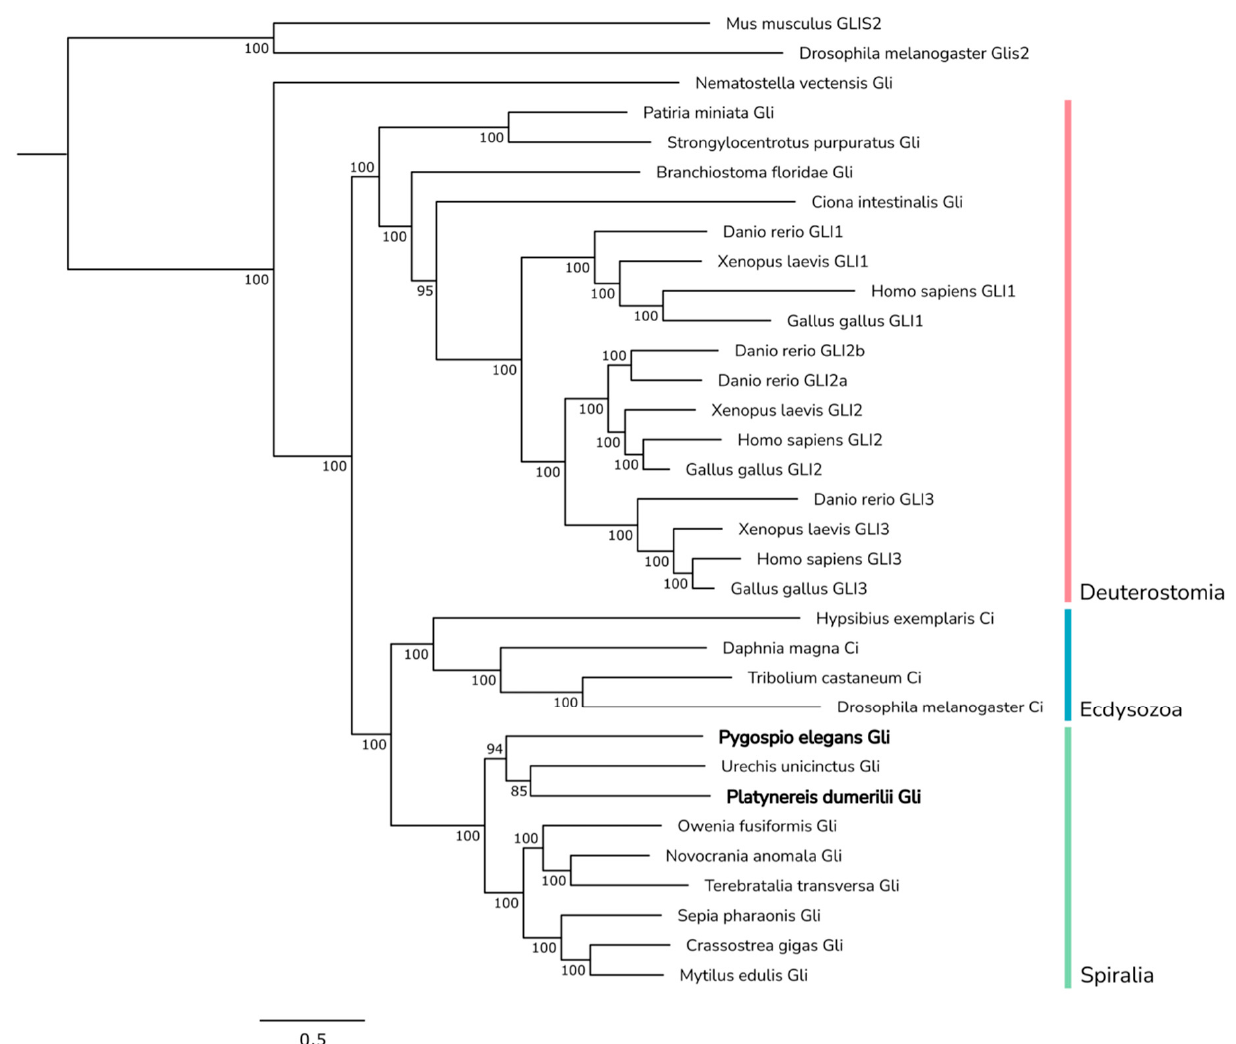
Figure 10. Phylogenetic analysis of Gli proteins. Pele-Gli and Pdum-Gli fell into one clade with Gli from the echiurid Urechis unicinctus . GLI-similar 2 (Glis2) proteins from mouse and fruit fly were used as an outgroup. Numbers near branch nodes indicate Bayesian posterior probabilities. Bayesian posterior probability values less than 75 are not